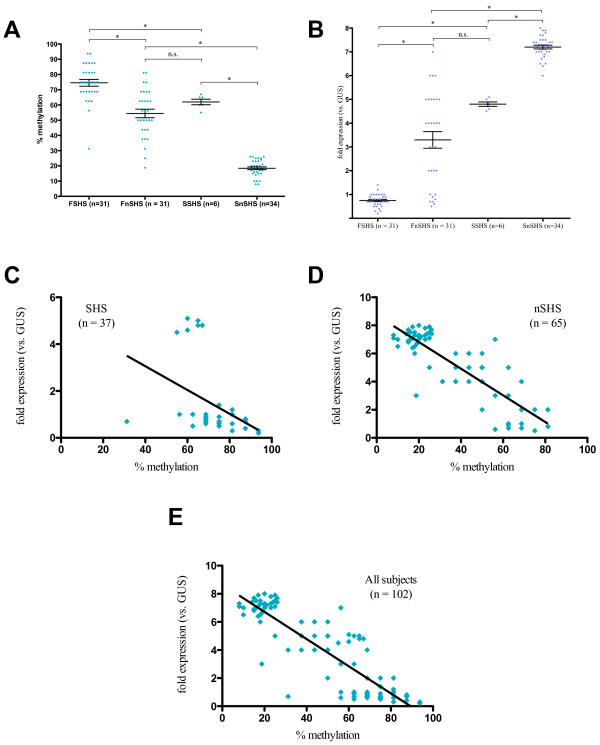
Methylation and expression of Foxp3 in T regulatory cells (Tregs) of all subjects. A. Comparison of overall methylation of examined cytosine nucleotide neighboring guanine (CpG) sites in Foxp3 in Tregs between Fresno subjects exposed to secondhand smoke (SHS) (FSHS) (n = 31), Fresno subjects not exposed to SHS (FnSHS) (n = 31), Stanford subjects exposed to SHS (SSHS) (n = 6), and Stanford subjects who were not exposed (SnSHS) (n = 34) groups. Methylation is reported as percent methylated CpG sites out of 13 total examined CpG sites; the cutoff for positive methylation at each site was set at 70% of all sequencing reactions. Error bars represent standard error of the mean (SEM). B. Comparison of expression of Foxp3 in Tregs between FSHS, FnSHS, SSHS, and SnSHS groups. Expression is reported as fold expression relative to the expression of the housekeeping gene beta-glucuronidase (GUS). Error bars represent SEM. C. Linear regression analysis of Foxp3 expression in Tregs vs. % methylation of Foxp3 from all SHS subjects. D. Linear regression analysis of Foxp3 expression in Tregs vs. % methylation of Foxp3 in all nSHS subjects. E. Linear regression analysis of Foxp3 expression in Tregs from all subjects vs. % methylation of Foxp3. *P < 0.05; n.s., not significant.